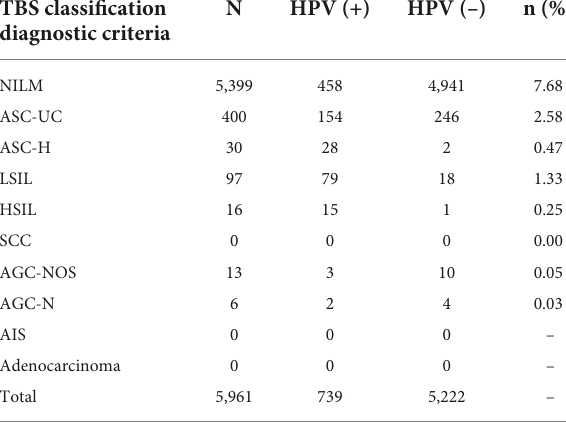
TABLE 7 Thinprep cytology test (TCT) and HPV cervical cancer screening